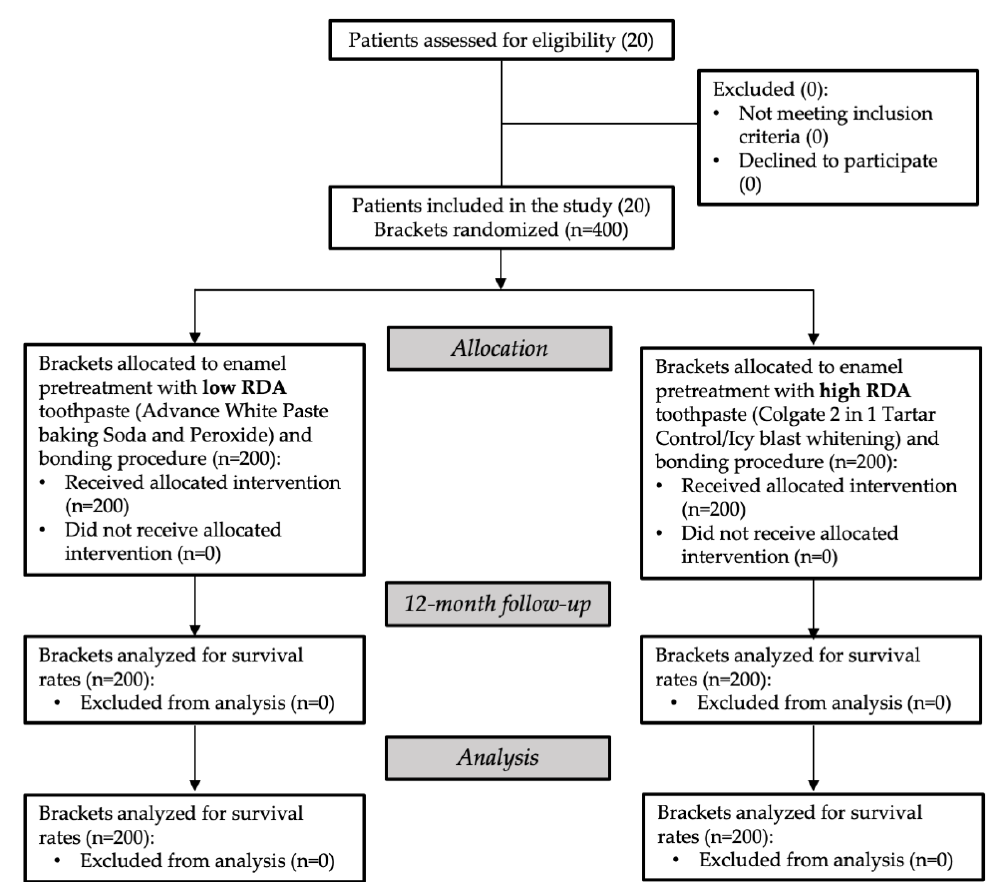
Figure 2. Flow chart showing participants and protocol used in this study.